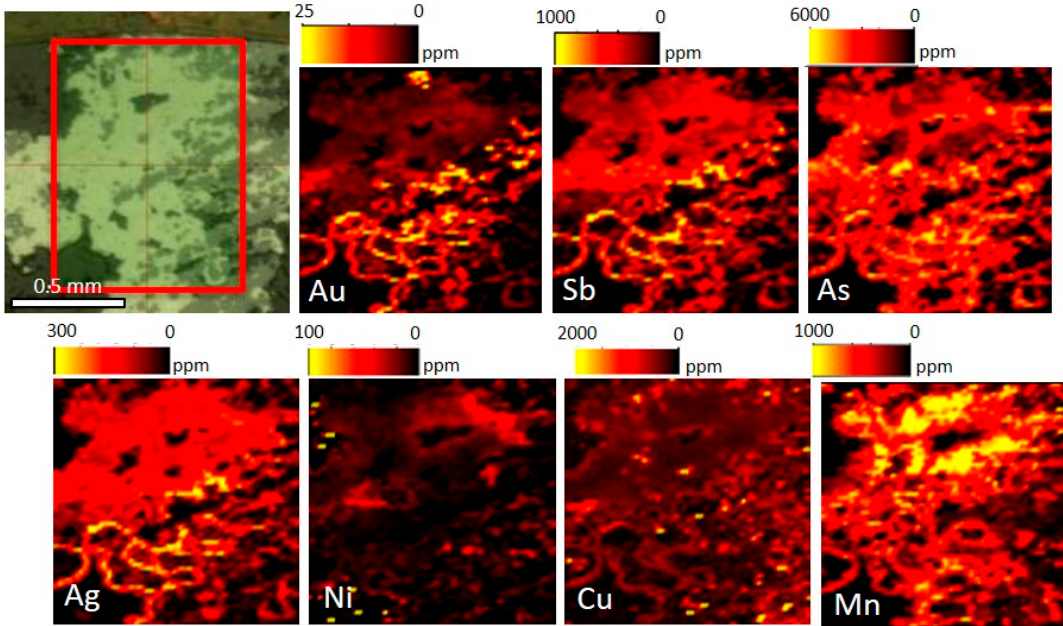
Figure 8. Au, Ag, As, Sb, Ni, Cu and Mn distribution maps of colloform banded pyrite (Py III) aggregate 1 from sample Cast-004. The maps show semi-quantitative values.